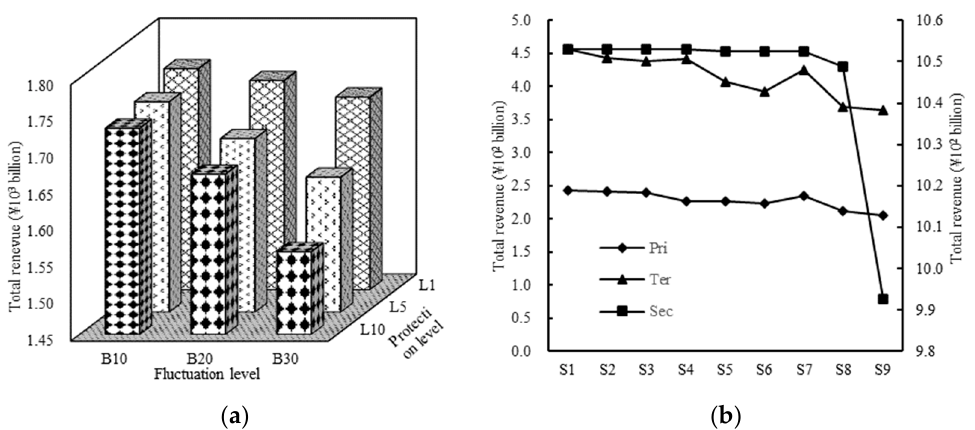
Figure 13. Industry scale changes under nine scenarios. ( a ) Comparison of objective value. ( b ) Com- parisons of the industry’s output.